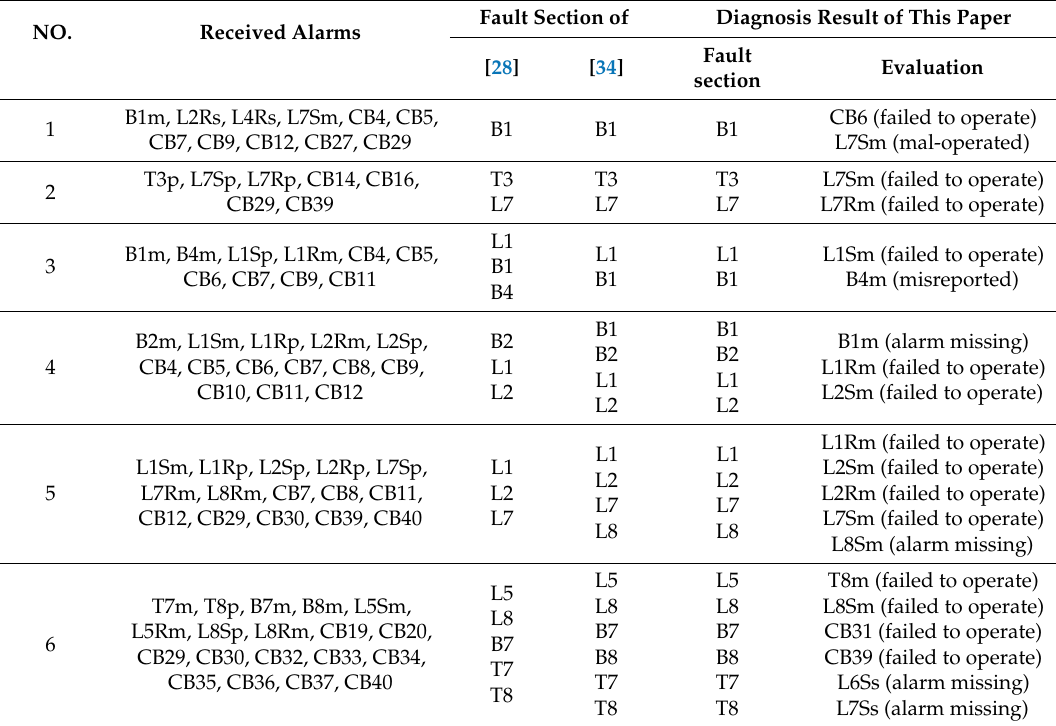
Table 2. Diagnosis results of the four-zone power